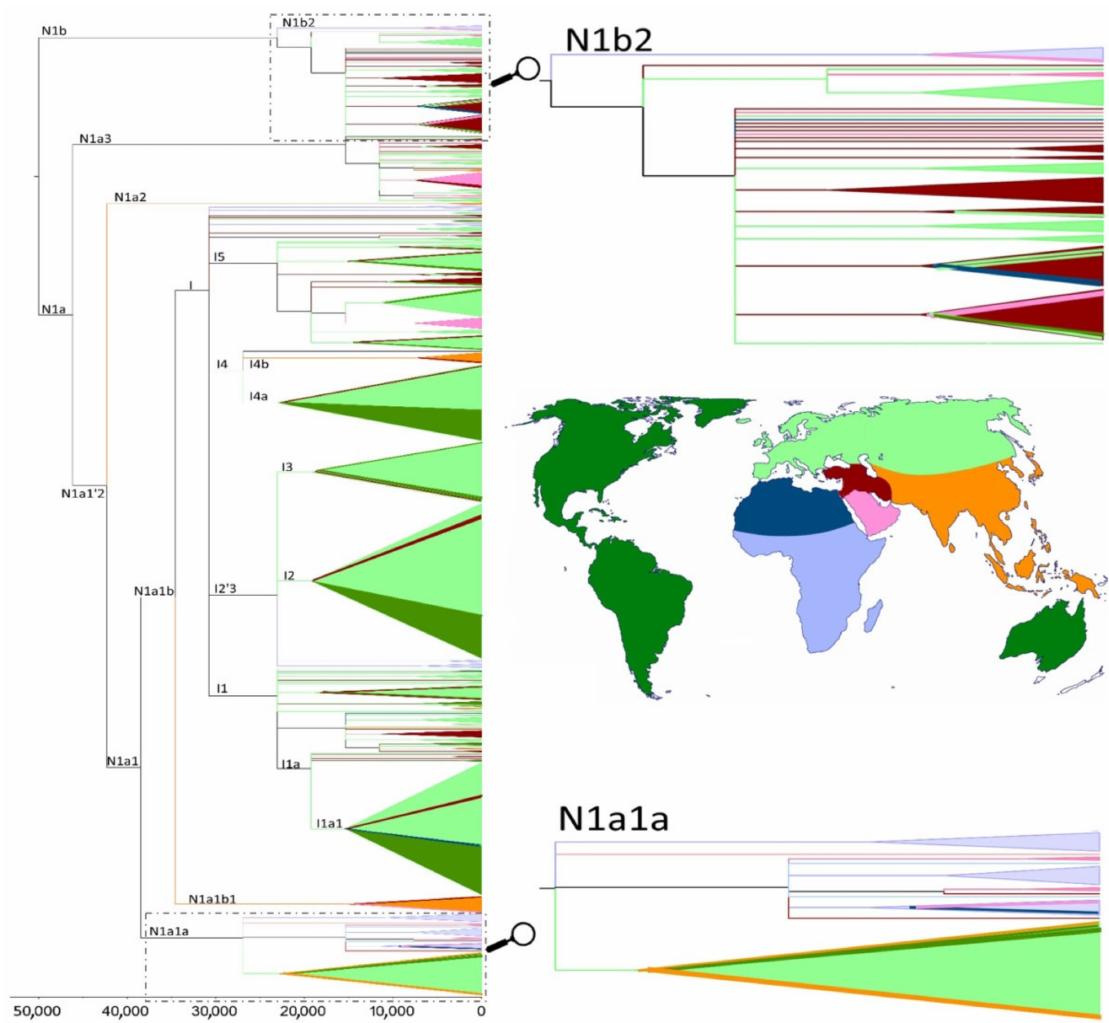
Figure 6. Phylogenetic reconstruction of mtDNA haplogroup N1, with time scale for the most recent common ancestors of the branches. Colors used in the tree correspond to the geographical regions illustrated in the map. Zooms of the N1a1a and N1b2 parts of the tree allow us to observe a closer relationship between the Sahel/Savannah belt and Arabian